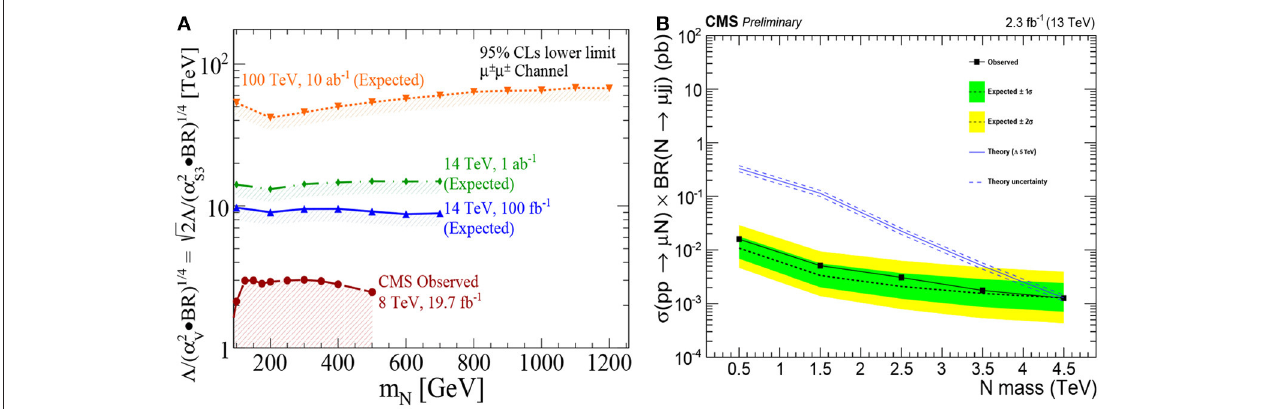
FIGURE 22 | Observed limits and expected sensitivities at current and future hadron collider experiments on NEFT mass scale 3 for (A) low-mass [163] and (B) high-mass [59] Majorana neutrinos N via the L -violating pp